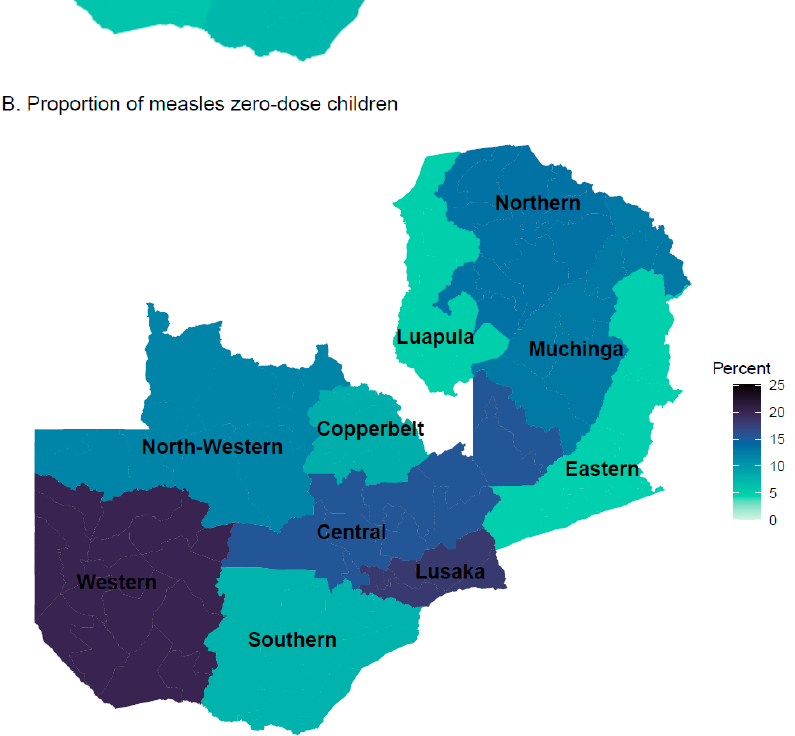
Figure 4. Receipt of measles and rubella vaccine among children 9–59 months post SIA, including documented or recalled evidence of vaccination. 0 dose: children who had a documented record or recalled not having received any MCV doses though routine immunization or SIA; 1 routine dose: children who had a documented record or recalled having received MCV1 through routine immun- ization; 2 routine doses: children who had a documented record or recalled having received MCV1 and MCV2 through routine immunization; 1 SIA dose: children who had a documented record or recalled not having received any MCV through routine immunization and a had documented record